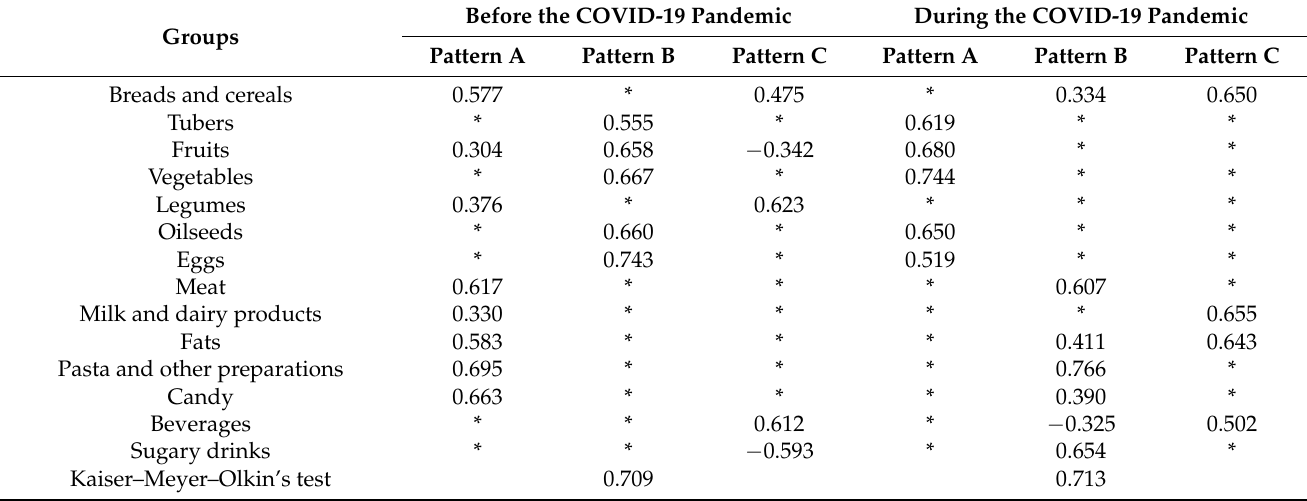
Table 2. Food group factor loadings of the workers’ dietary patterns identified for before and